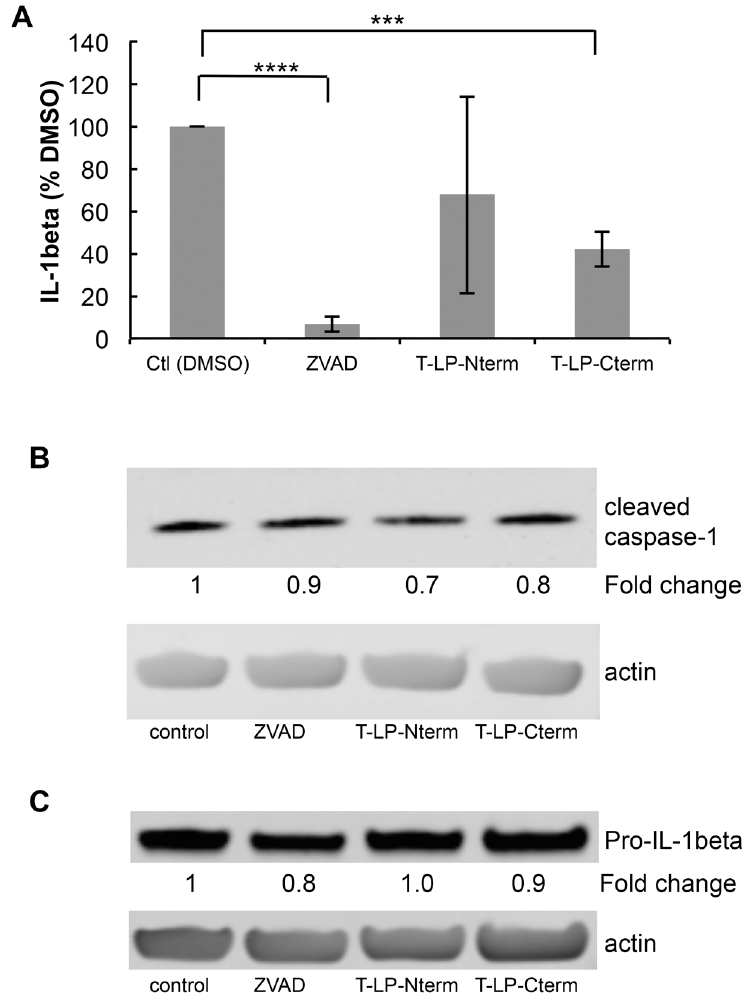
Fig 6. Peptides containing LANA caspase cleavage sites inhibit IL-1 β production. Cell permeable peptides with an N-terminal cellular HIV-1 Tat delivery sequence RKKRRQRRR containing the N-terminal caspase cleavage site of LANA (T-LP-Nterm) or the C-terminal caspase cleavage site of LANA (T-LP-Cterm) were tested as potential inhibitors of IL-1 β production following treatment of THP-1 cells with LPS. ZVAD was used as a positive caspase inhibitor control. (A) Effect of ZVAD (50 μ M), T-LP-Nterm (50 μ M) and T-LP-Cterm (50 μ M) on IL-1 β in the supernatant from THP-1-treated cells. Δ ata is from five separate experiments (except for T-LP-Nterm, 4 experiments). *** , P < 0.0005, **** P < 0.0001 for two tailed paired Student ’ s t-test. The average IL-1 β λεωελ ϕ ορ untreated and LPS treated THP-1 cells was 276 pg/ml and 2344 pg/ml, respectively. (B) Immunoblot analysis for cleaved (mature) caspase-1 and actin as a loading control. The fold change in cleaved caspase expression normalized to β -actin is shown just below the immunoblot using the LiCor system. (C) Immunoblot analysis for Pro-IL-1 β and actin as a loading control. The fold change in Pro-IL- 1 β expression normalized to β -actin is shown just below the immunoblot using the LiCor